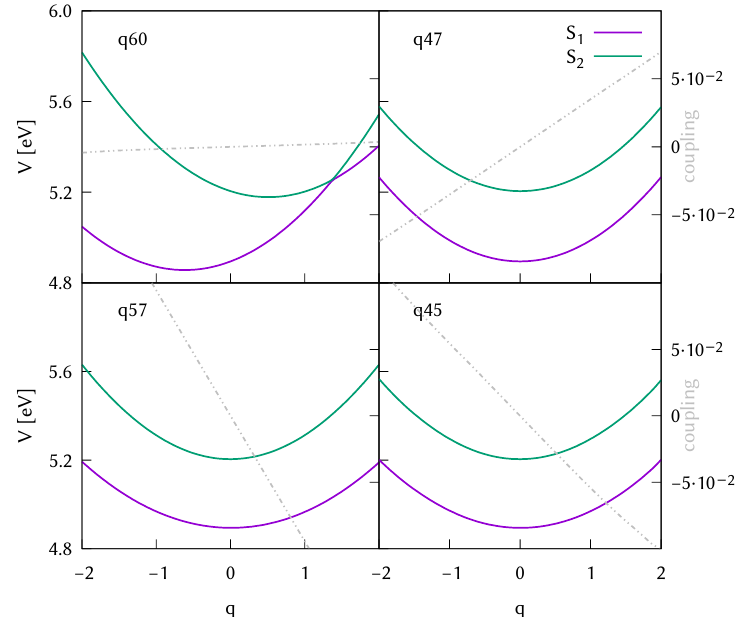
Figure 6. Potential energy surfaces along the four most important normal modes: symmetric C=C stretching and three N-Me 2 tilting modes plotted from the database of 220 ab initio points resulting from the TDA-wB97X-D3/cc-pVDZ DD-vMCG dynamics in the water cluster started from the state L a (S 2 ). The diabatic coupling along those modes is plotted in grey for